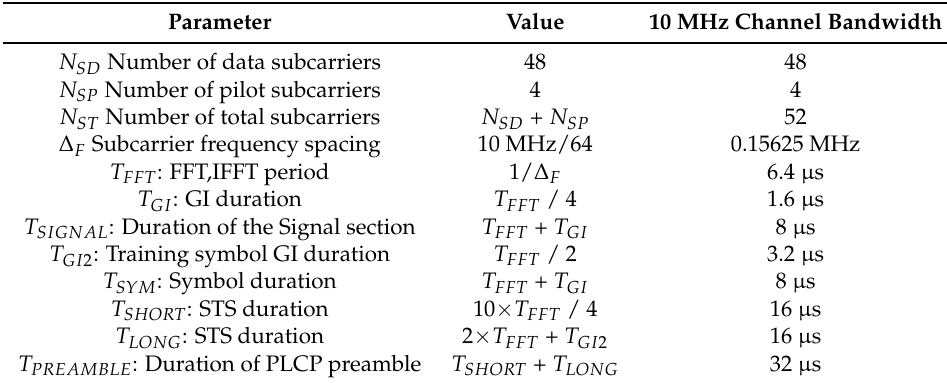
Table 4. Timing parameters used in the proposed